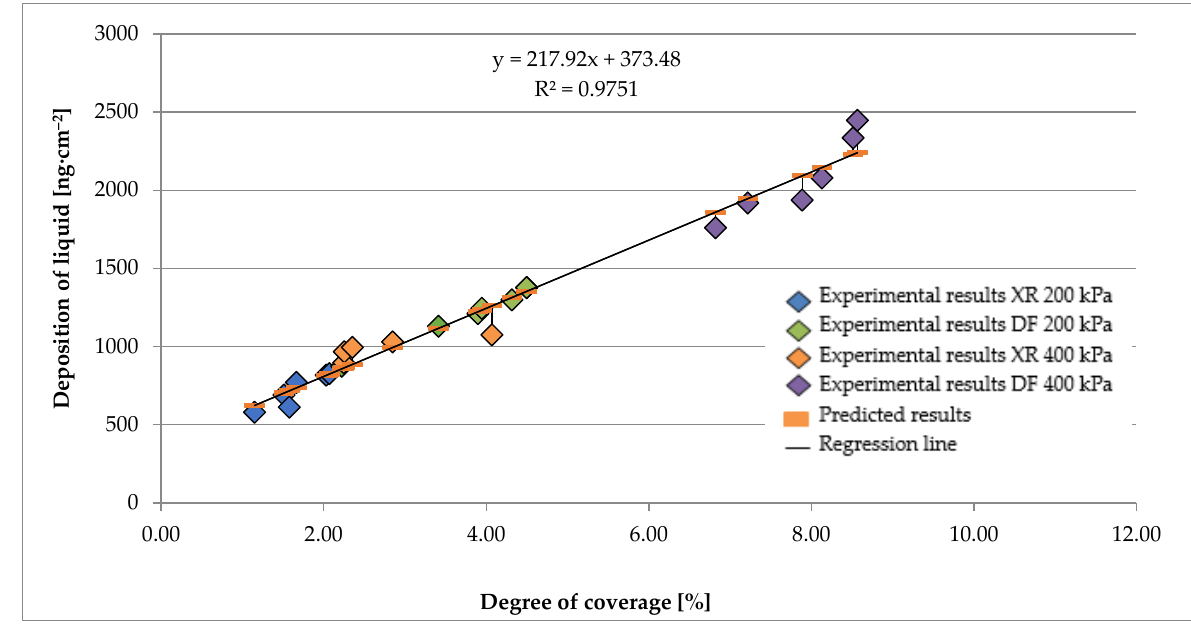
Figure 6. The scatter plot of the degree of coverage and deposition of spray liquid for selected standard nozzles for leaving the vertical surface.